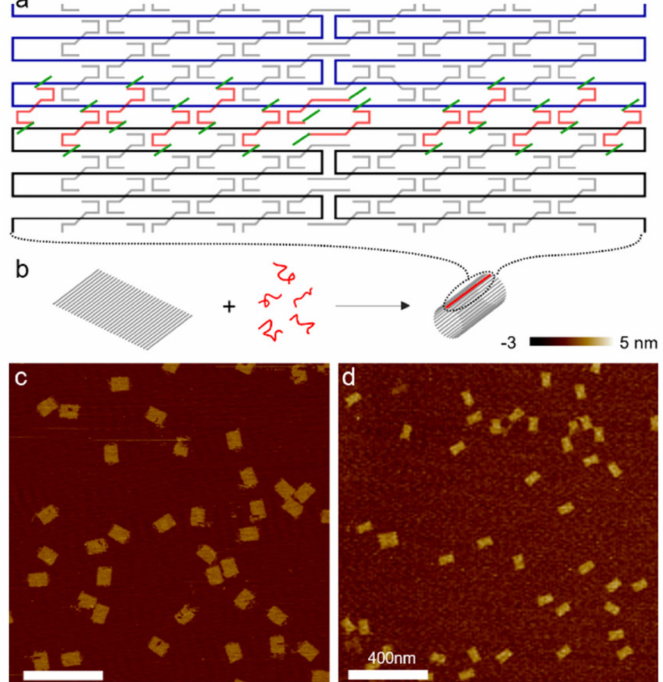
Figure 2. ( a ) Schematic of a portion of a single-layer DNA origami rectangle with its upper and lower boundaries (black and blue) connected and sealed by a set of linker strands (red) with toeholds (green) at both ends. Staple strands in the origami tile are shown in gray. ( b ) Schematic of DNA origami cyclization. A flat tile bends and cyclizes into a short cylinder with the help of the linkers (red). Gray rods represent DNA double helices. The sealed boundaries are indicated by red lines. ( c , d ) AFM images of the two origami tile species. ( c ) All origami tiles formed by thermal annealing are flat. ( d ) Cyclized DNA origami after incubation of flat tiles with linkers at 50 ◦ C for 2 h. The majority of DNA origami measures half the length of the flat tile with twice thickness. (Contents in this figure were previously published. Adapted with permission from [37]. Copyright (2014) American Chemical